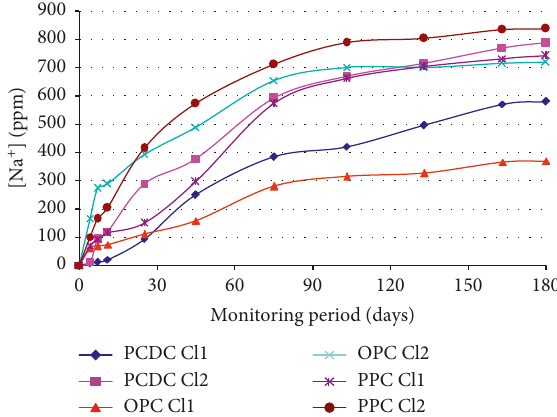
Figure 6: Na + analyses in simulated chloride solutions.